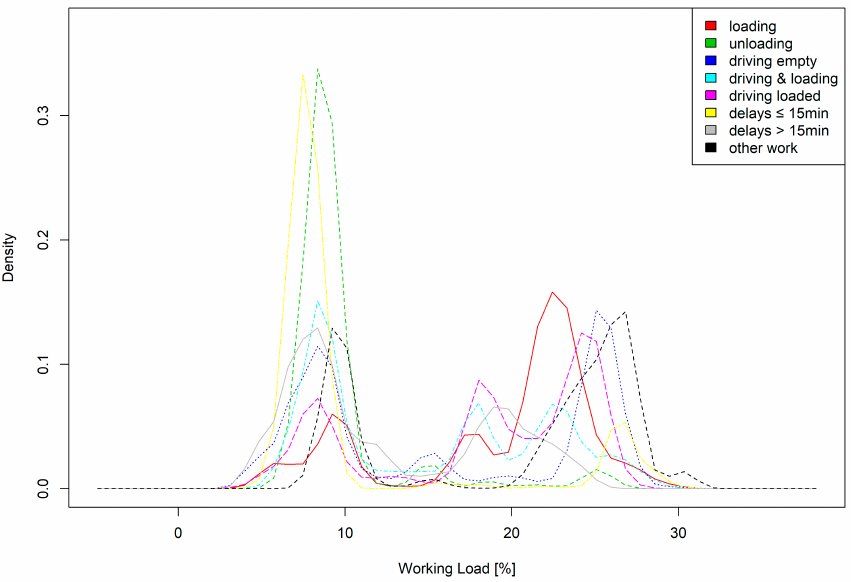
Figure 11. Working load for the cable used during forwarding activities divided into the defined work phases.